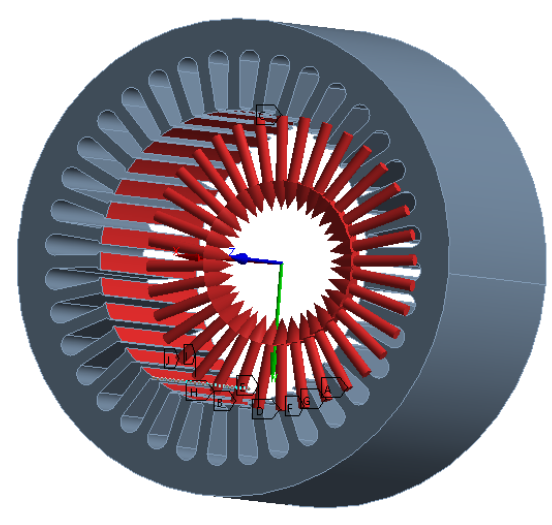
Figure 9. Electromagnetic and structural field coupling.